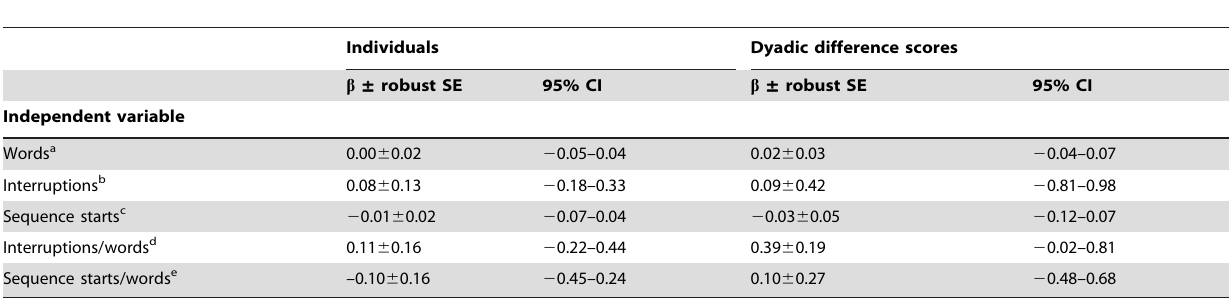
Table 4. Linear regressions of conversational dominance variables on standardized male facial